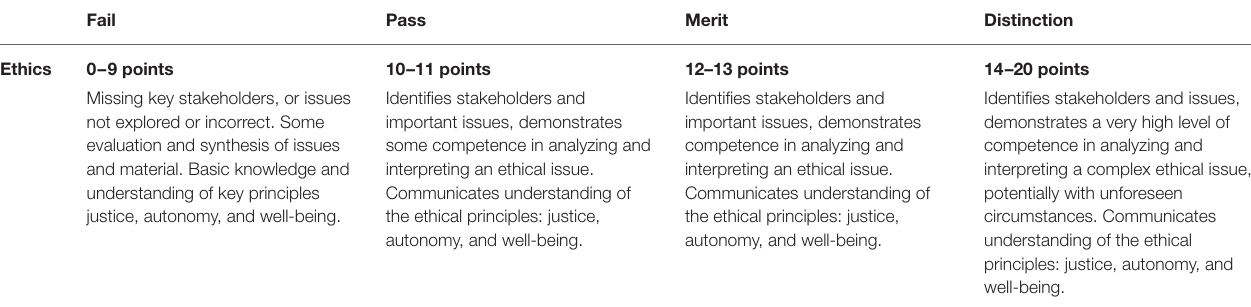
TABLE 1 | Sample row from bioethics rubric reproduced from Hack